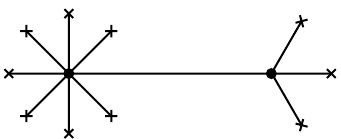
Figure 2 . The leading contribution to the connected two-point function of scalar operators. The operators are represented by a dot and a cross symbolises the insertion of the classical